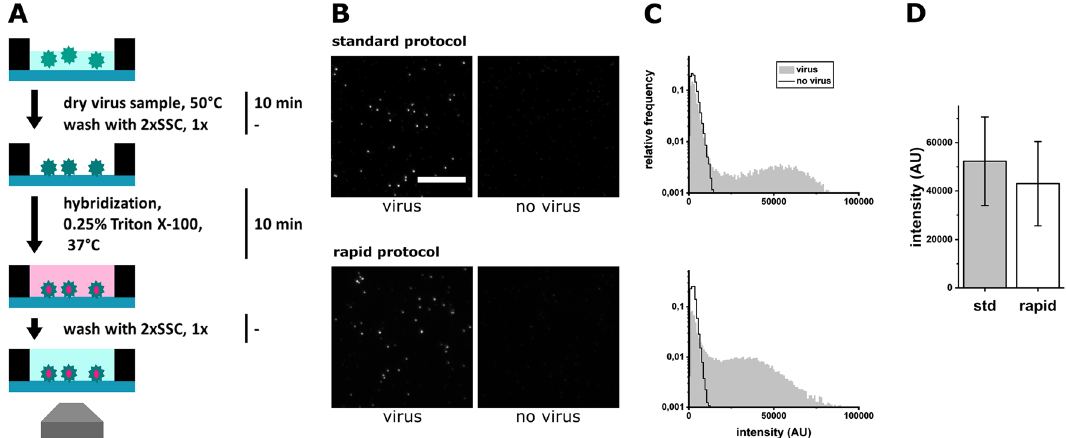
Figure 2. Efficiency of the rapid FISH protocol for virus detection. ( A ) Schematic depiction and summary of the rapid virus detection FISH protocol with incubation times. WSN particles were stained with FISH probes against WSN. ( B ) Comparison of FISH protocols. Top row: Standard protocol (see Fig. 1A). Bottom row: rvFISH (see A ). Left panels: WSN particles at concentration of 10 6 PFU/mL 35 , hybridization time 1 h. Right panels: FISH staining (Fig. 1B) in the absence of virus. Scale bar 10 µm. ( C ) Intensity distributions of fluorescent spots detected in the samples in ( B ) Top: standard protocol, bottom: rvFISH protocol. ( D ) Average